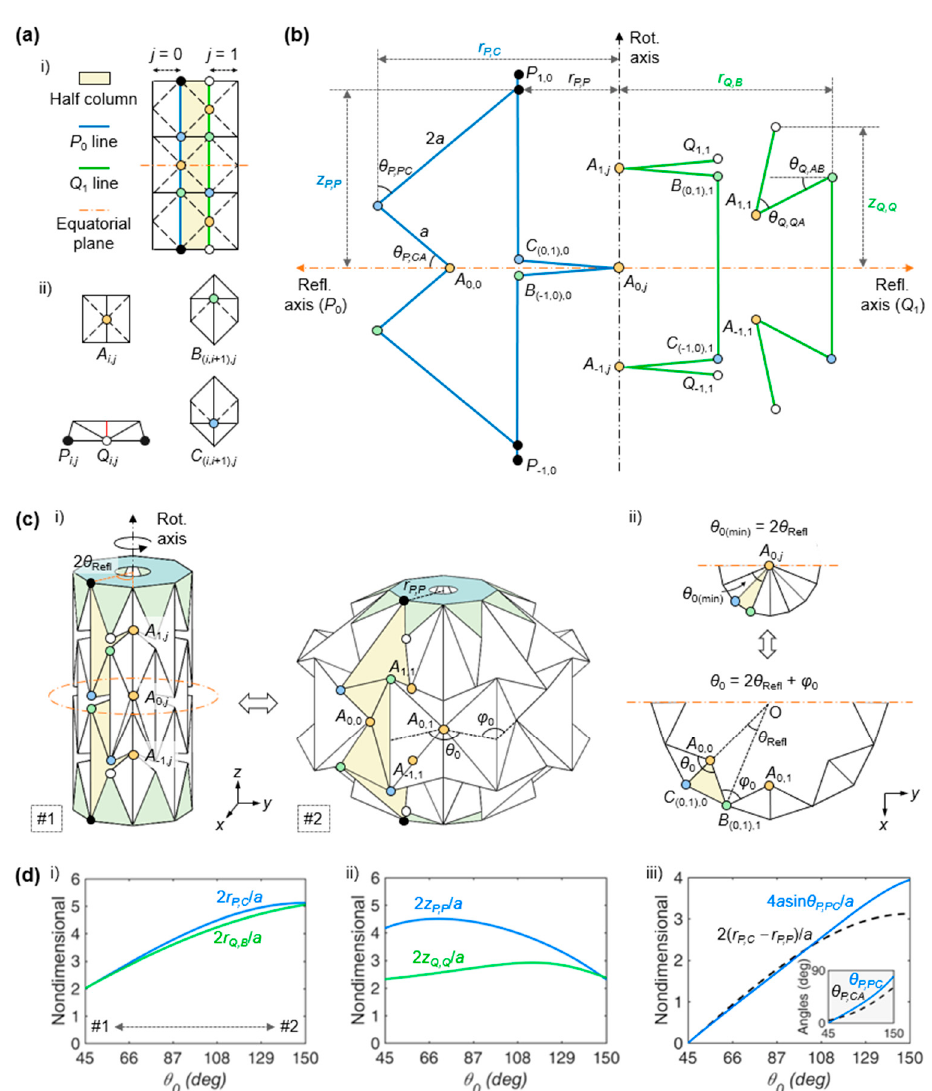
Figure 3. Kinematic model of the Waterbomb. ( a ) Vertex classification. (i) half-column of CPs; (ii) five types of vertices, represented by solid circles in yellow, green, blue, black, and white. ( b ) The motion paths of the P 0 and Q 1 lines. ( c ) #1 and #2. (i) main view; (ii) half-column of the projected view on the equatorial plane. ( d ) Model solution. (i) radial length; (ii) axial length; (iii) geometric